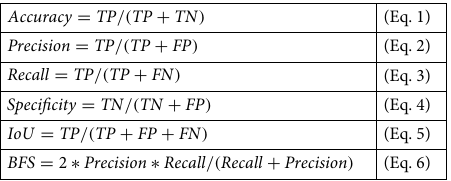
Table 1. Employed